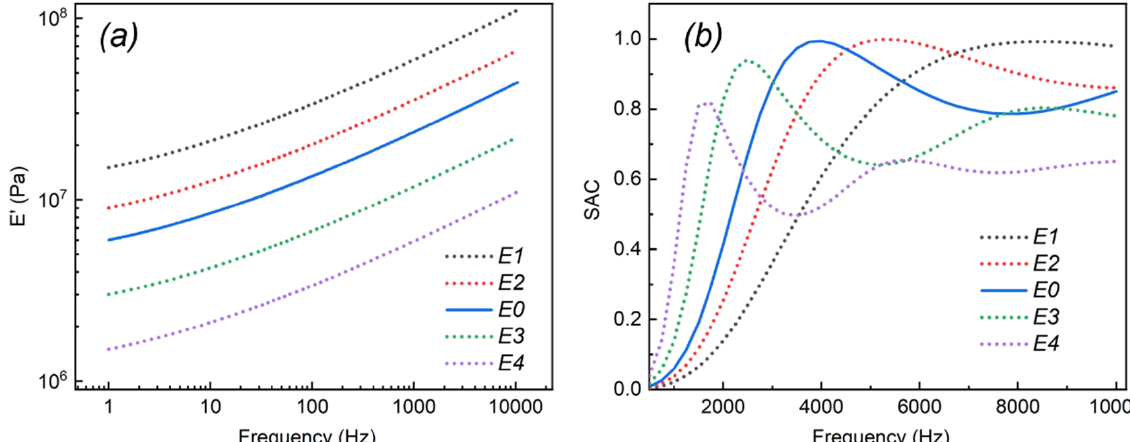
Figure 1. ( a ) E’ settings with different gradients. ( b ) The SAC results of the PU ‐ based composite Figure 1. ( a ) E (cid:48) settings with different gradients. ( b ) The SAC results of the PU-based composite with with different E’. different E (cid:48)